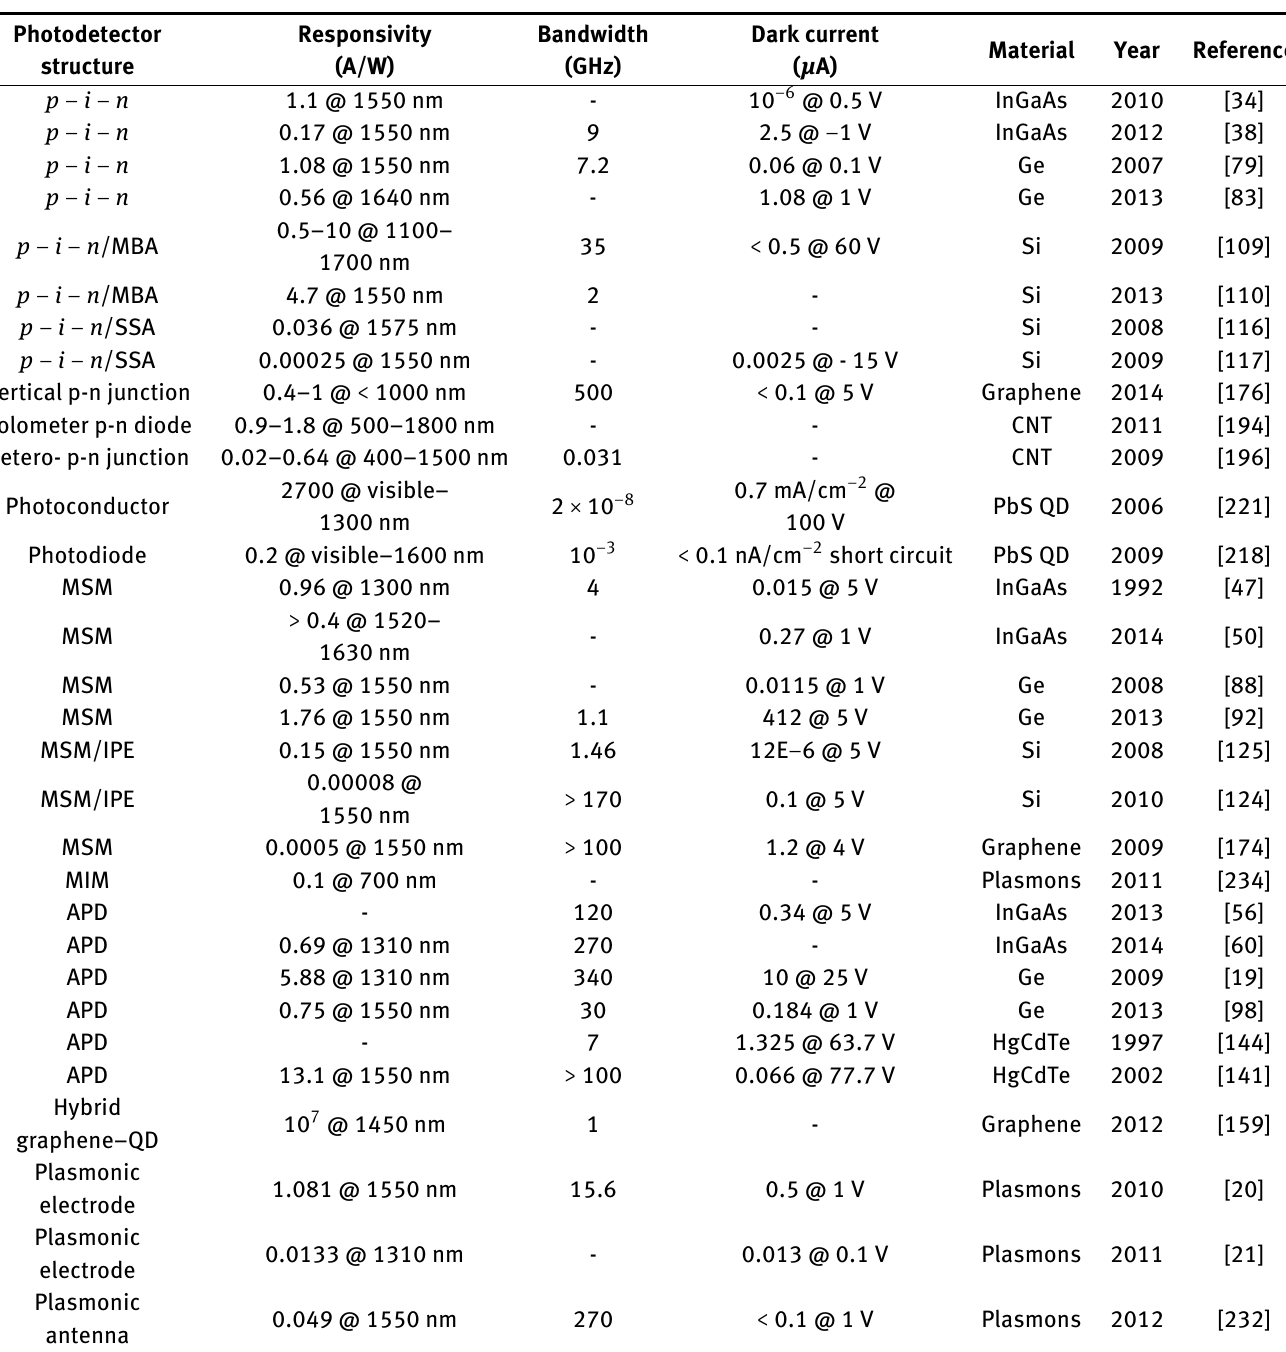
Table 2: Performance comparison for photodetectors based on various photodetector structures.